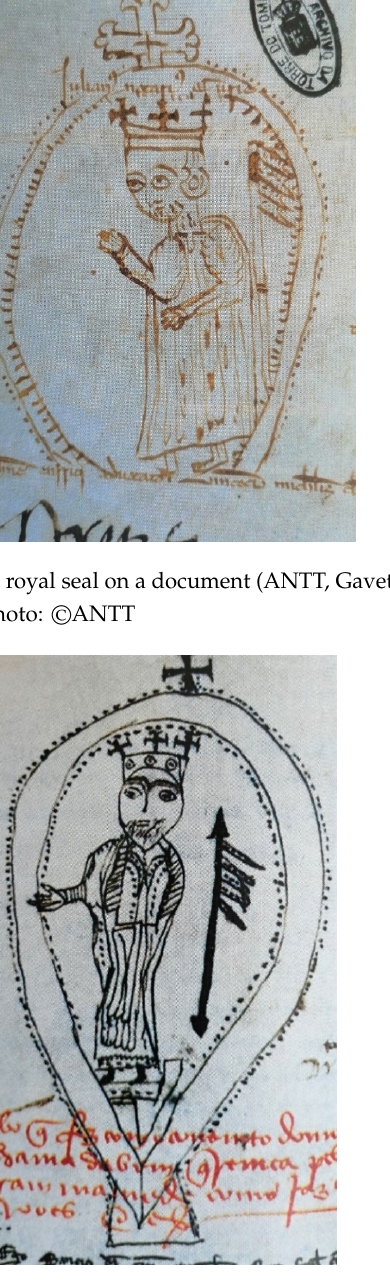
Figure 4. Sancho I. Drawing of the royal seal on a document from the Donations Book of Afonso III, fol. 13v°. 14th century. Photo: ©ANTT